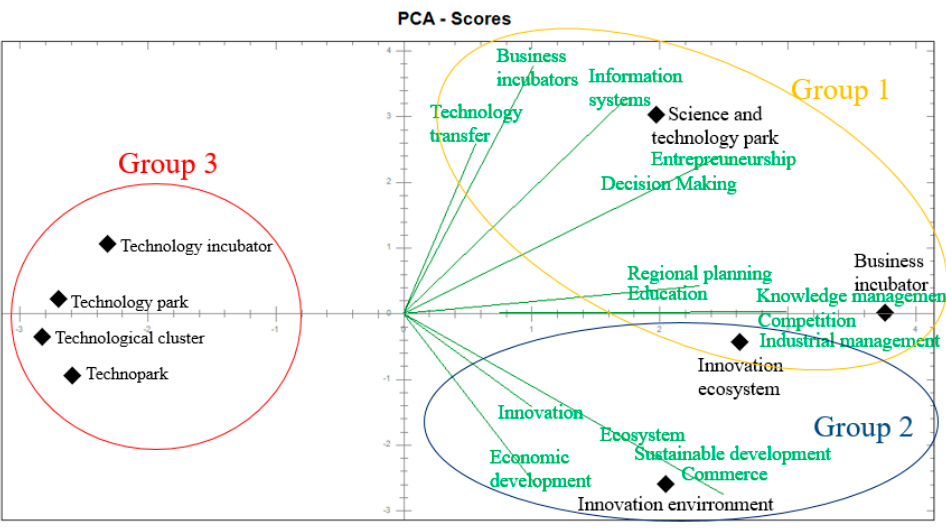
Figure 7. Biplot PCA Scores